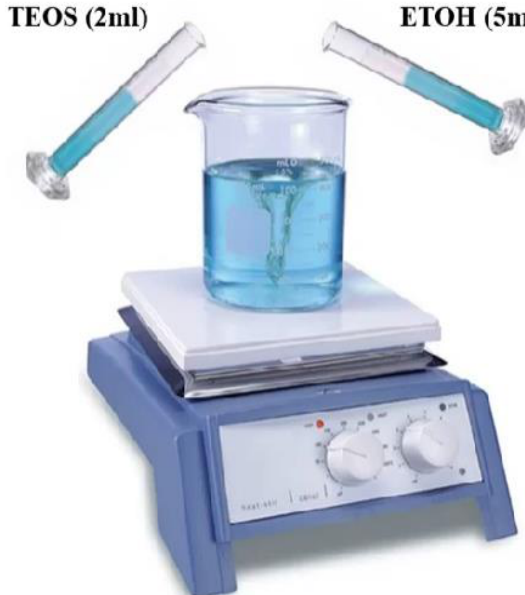
Figure 1. Synthesis method of SIO 2 nanoparticles.